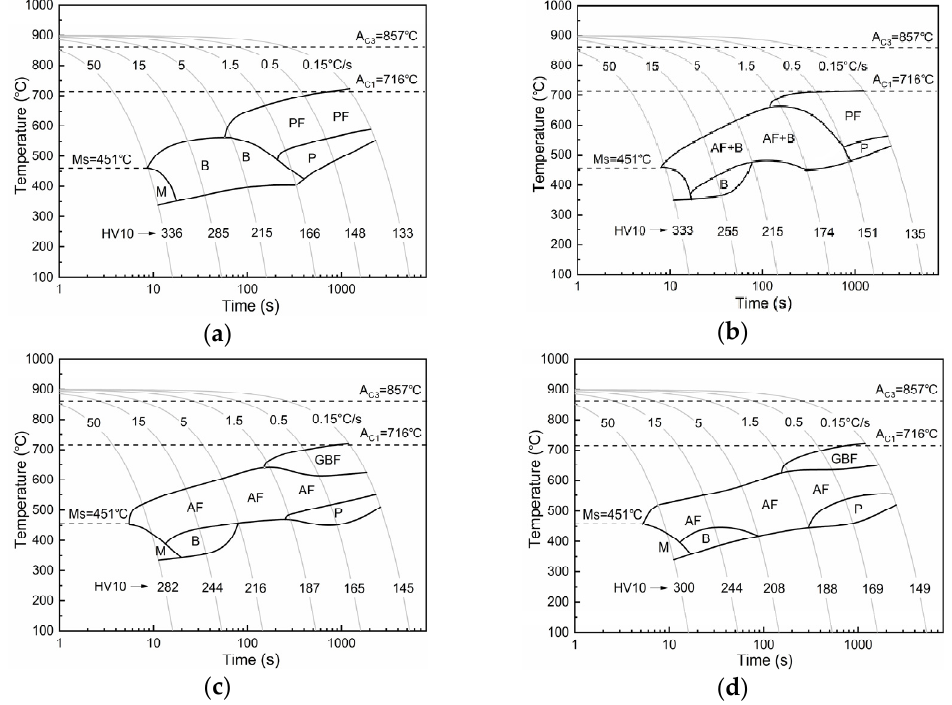
Figure 2. Continuous cooling transformation (CCT) diagrams of test steel austenitized at ( a ) 950 °C, ( b ) 1050 °C, ( c ) 1150 °C, and ( d ) 1250 °C. ( b ) 1050 ◦ C, ( c ) 1150 ◦ C, and ( d ) 1250 ◦